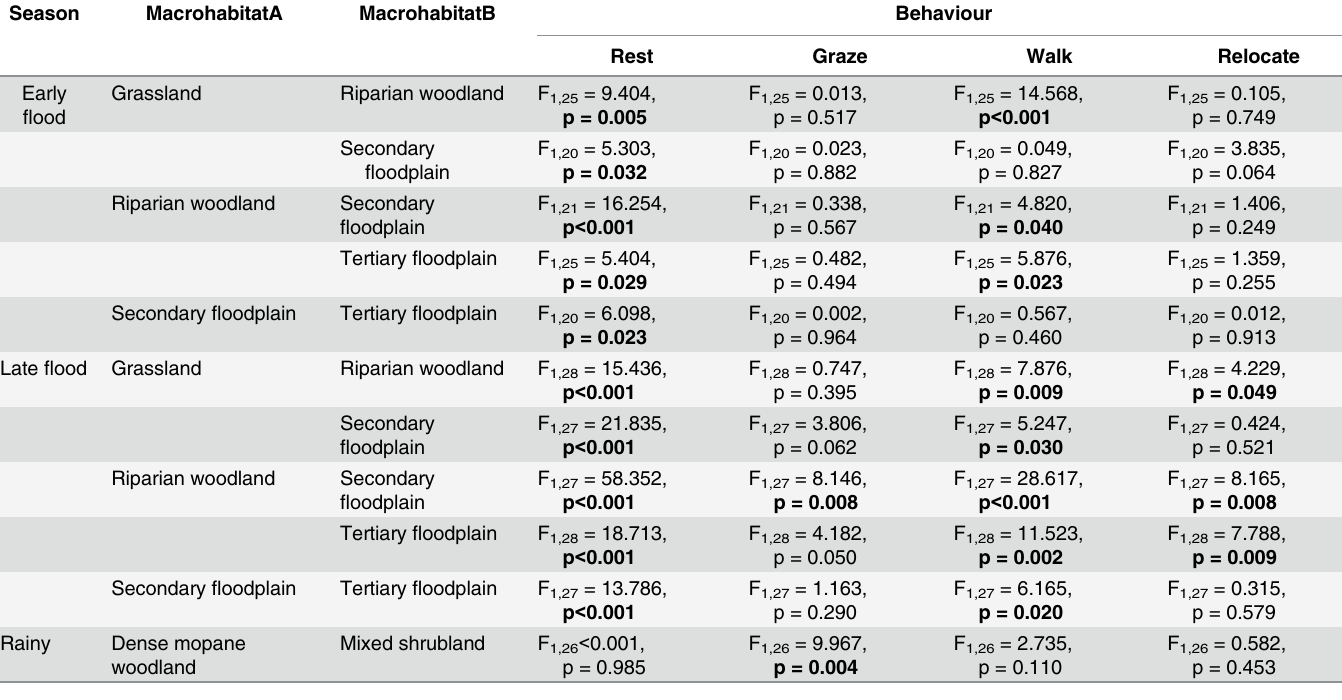
Table 4. ANOVA results identifying behaviours causing differences in proportional behaviour between seasonally-preferred